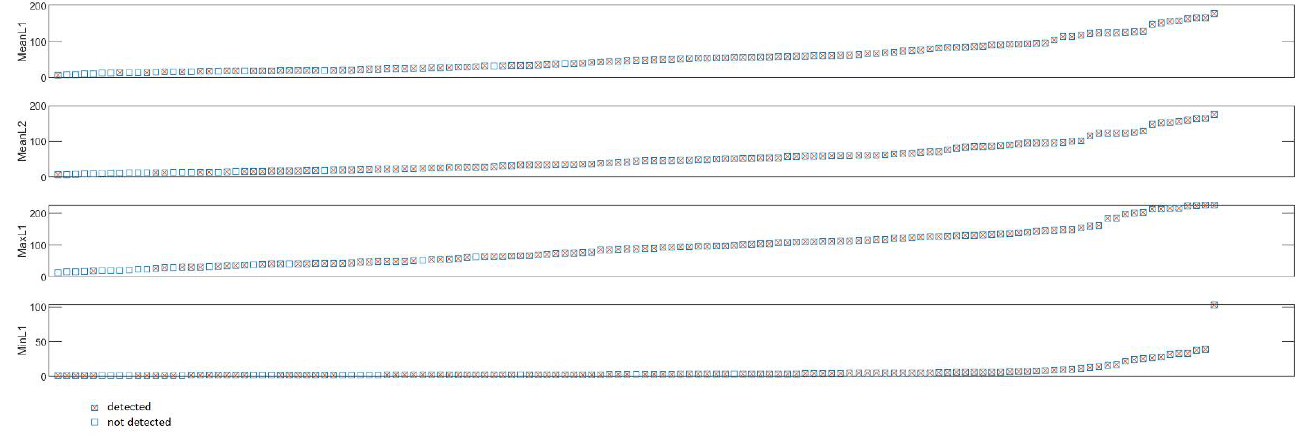
Figure 10. Analysis of the F-points’ detection ability, depending on the luminosity.